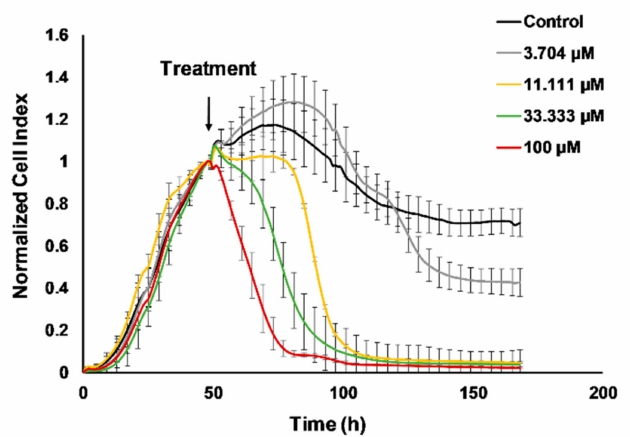
Figure 1. Real-time monitoring of 4T1 cell viability hampered by cisplatin. The 4T1 cells were seeded and the baseline impedance was recorded for 48 h. After that 48 h culturing treatment with 11.111 µ M, 33.333 µ M, or 100 µ M cisplatin reduced viability of 4T1 cells on a time and dose dependent manner. The corresponding dose-response curves with the half maximal inhibitory concentration (IC 50 ) values can be found in Figure